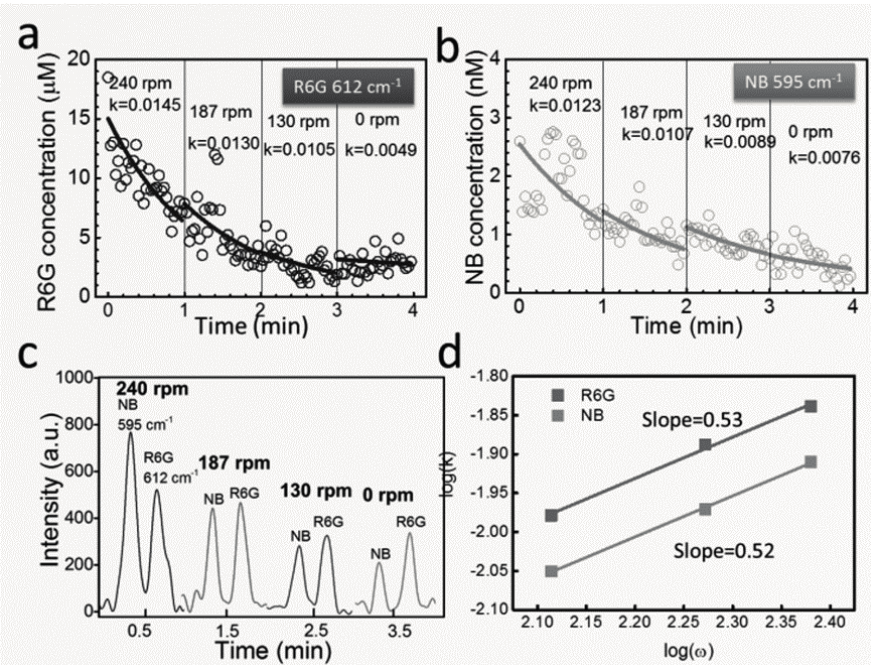
Figure 18. ( a , b ) Time dependent release of bi-analytes [NB (a) and R6G (b)] at different rotation speeds; ( c ) Raman spectra of NB and R6G every 1 min with different rotation speeds; ( d ) The power-law dependence of release rates of both analytes of NB and R6G versus the rotation speed. With permission from [106].